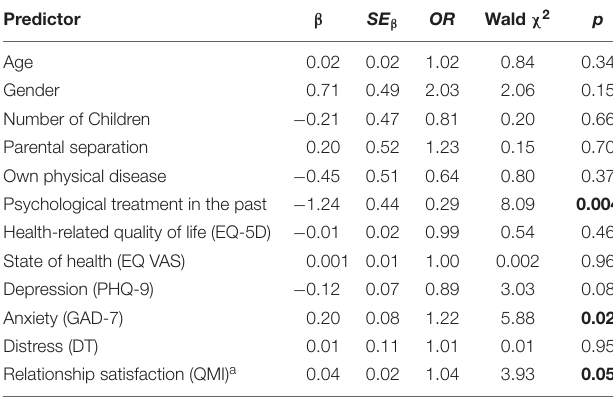
TABLE 3 | Coefficients from binary logistic regression of relationship dissolution ( N = 233) 1